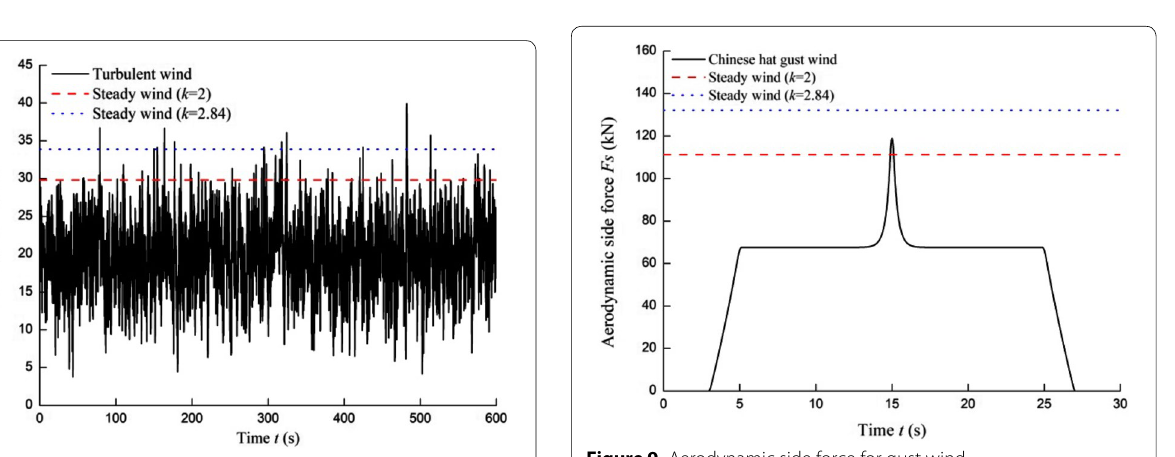
Figure 7 Time history of turbulent wind